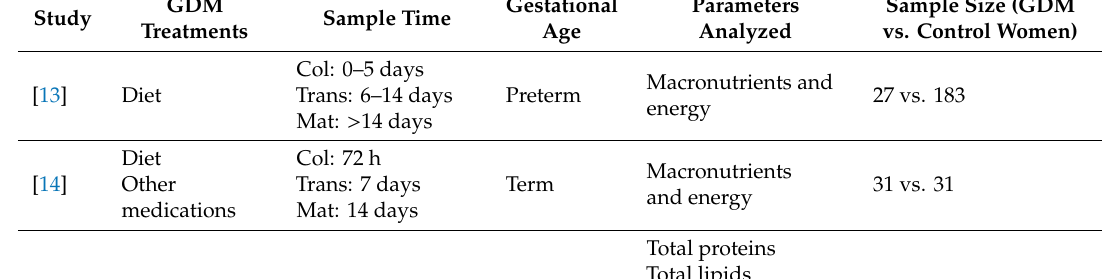
Table 1. Materials and methods of the di ff erent studies included in the survey regarding gestational diabetes mellitus (GDM) and human milk (HM). (Col: colostrum; Trans: Transitional milk; Mat: Mature